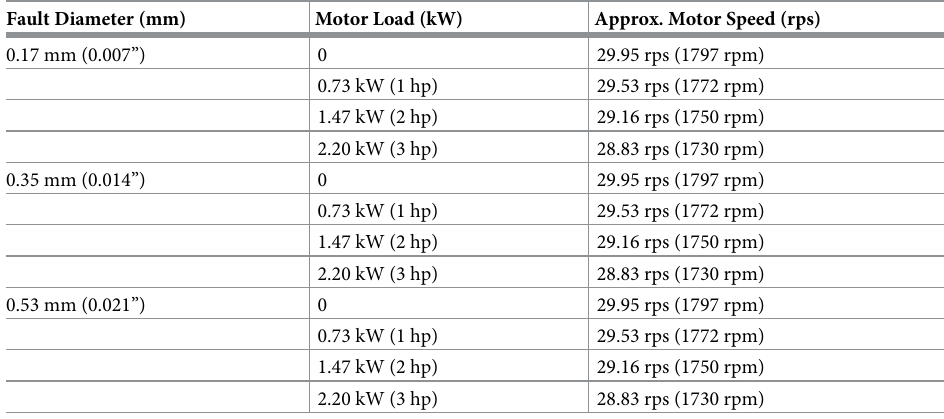
Table 2. Drive-end bearing and fan-end bearing data for analysis